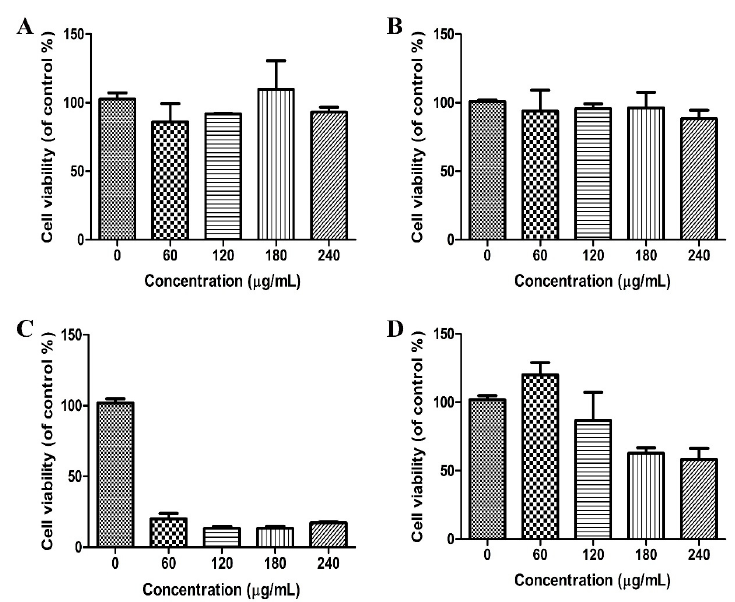
Figure 4. Cell viabilities of Lovo cells upon incubation with ( A ): 1.8 kD PEI; ( B ): HMSNs; ( C ): 25 kD PEI; and ( D ): PEI-HMSNs for 24 h, respectively. The number of independent determinations was at least three.